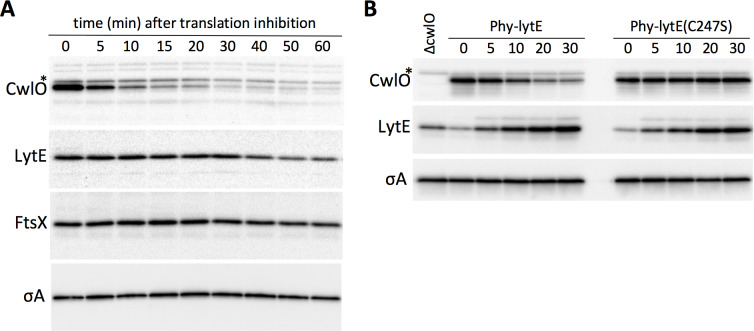
CwlO has a short half-life during exponential growth.(A) In vivo protein stability assays were performed in wild-type B. subtilis grown in LB medium at 37°C. CwlO, LytE, FtsX and SigA protein levels were assessed by immunoblot at the indicated times after translation was inhibited by addition of spectinomycin and chloramphenicol. An asterisk (*) highlights a stable cross-reacting protein that migrates slightly slower than CwlO. (B) CwlO levels are rapidly reduced upon over-expression of lytE. Immunoblot analysis of CwlO, LytE, and SigA levels after induction of lytE or the LytE catalytic mutant (C247S). Cells were grown in LB medium at 37°C. CwlO, LytE, and SigA levels were assessed before and at the indicated times after the addition of 50 µM IPTG. As LytE levels increase in response to IPTG induction, CwlO levels decrease due to a reduction in WalR-dependent transcription and the short half-life of the protein. The representative immunoblots in this figure are from one of three independent experiments.